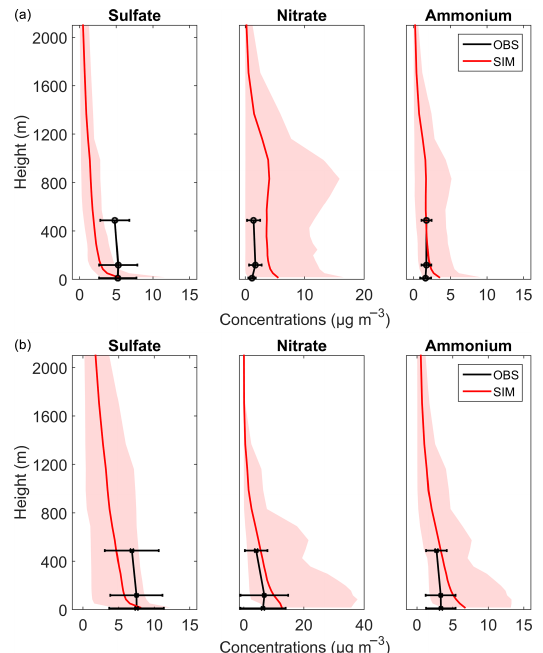
Figure 10. The vertical concentration profiles of sulfate, nitrate, and ammonium in PM 2 . 5 during (a) autumn and (b) winter. The solid red lines are the average modeled concentrations, and the shaded regions indicate the minimum and maximum values of the simu- lation. The average measurement data are in black with horizontal error